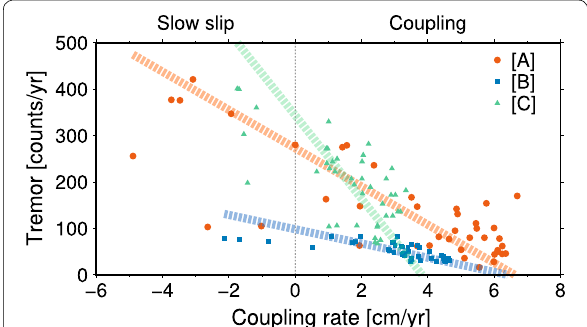
Fig. 5 Scatter plot of the coupling and tremor count rates at grids A–C that is depicted in Fig. 2 for all the 41 epochs between 2007.5 and 2015.5. Bold dashed lines denote the regression lines of the plots having the same